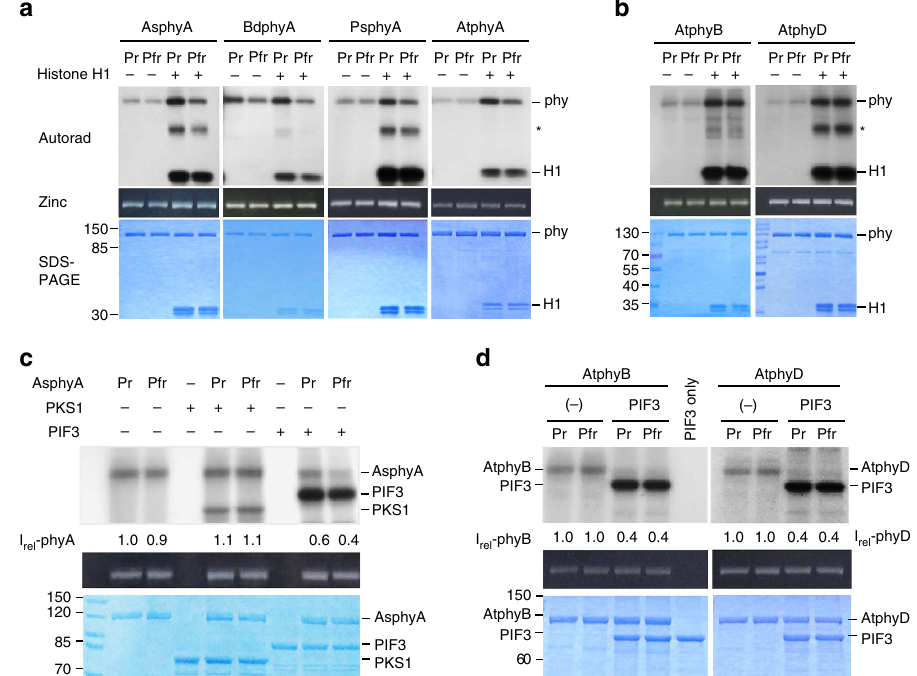
Figure 1 | Evidence that PIF3 is phosphorylated by phytochromes. ( a , b ) Autophosphorylation and protein kinase activities of type I ( a ) and type II ( b ) phytochromes. Histone H1 (H1) was included as a substrate for phytochrome kinase activity, and also used to stimulate phytochrome autophosphorylation. Autoradiograms (top), zinc-fluorescence assays (middle), and SDS-PAGE gels (bottom) are shown. The asterisk indicates a protein band that originated from histone H1 (see Supplementary Fig. 1). ( c , d ) Phosphorylation of PIF3 by AsphyA ( c ), and by AtphyB and AtphyD ( d ). In all, 1.0 m g of GST/strep-fused PIF3 ( B 0.3 m M) was included as a substrate and the reactions were performed in the absence of histone H1. PKS1 (phytochrome kinase substrate 1) was included as a control. Intensities (I rel ) of AsphyA, AtphyB and AtphyD autophosphorylation are expressed relative to the first lanes (that is, Pr forms in the absence of a substrate). AsphyA, Avena sativa (oat) phyA; AtphyA, AtphyB and AtphyD, Arabidopsis thaliana phyA, phyB and phyD; BdphyA, Brachypodium distachyon phyA; Pisum sativum phyA; Pr/Pfr, red/far-red light-absorbing forms of